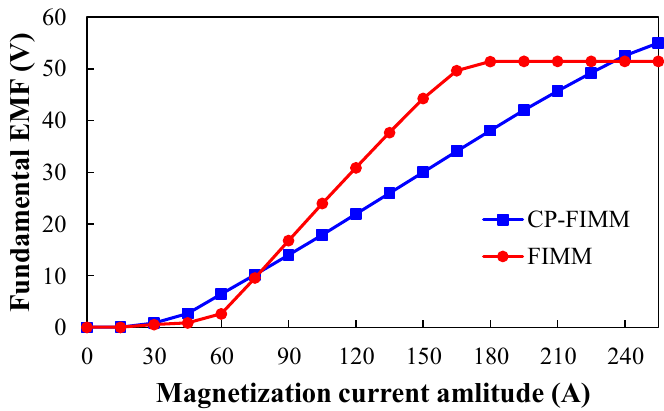
Figure 12. Fundamental back-EMF versus demagnetization current.